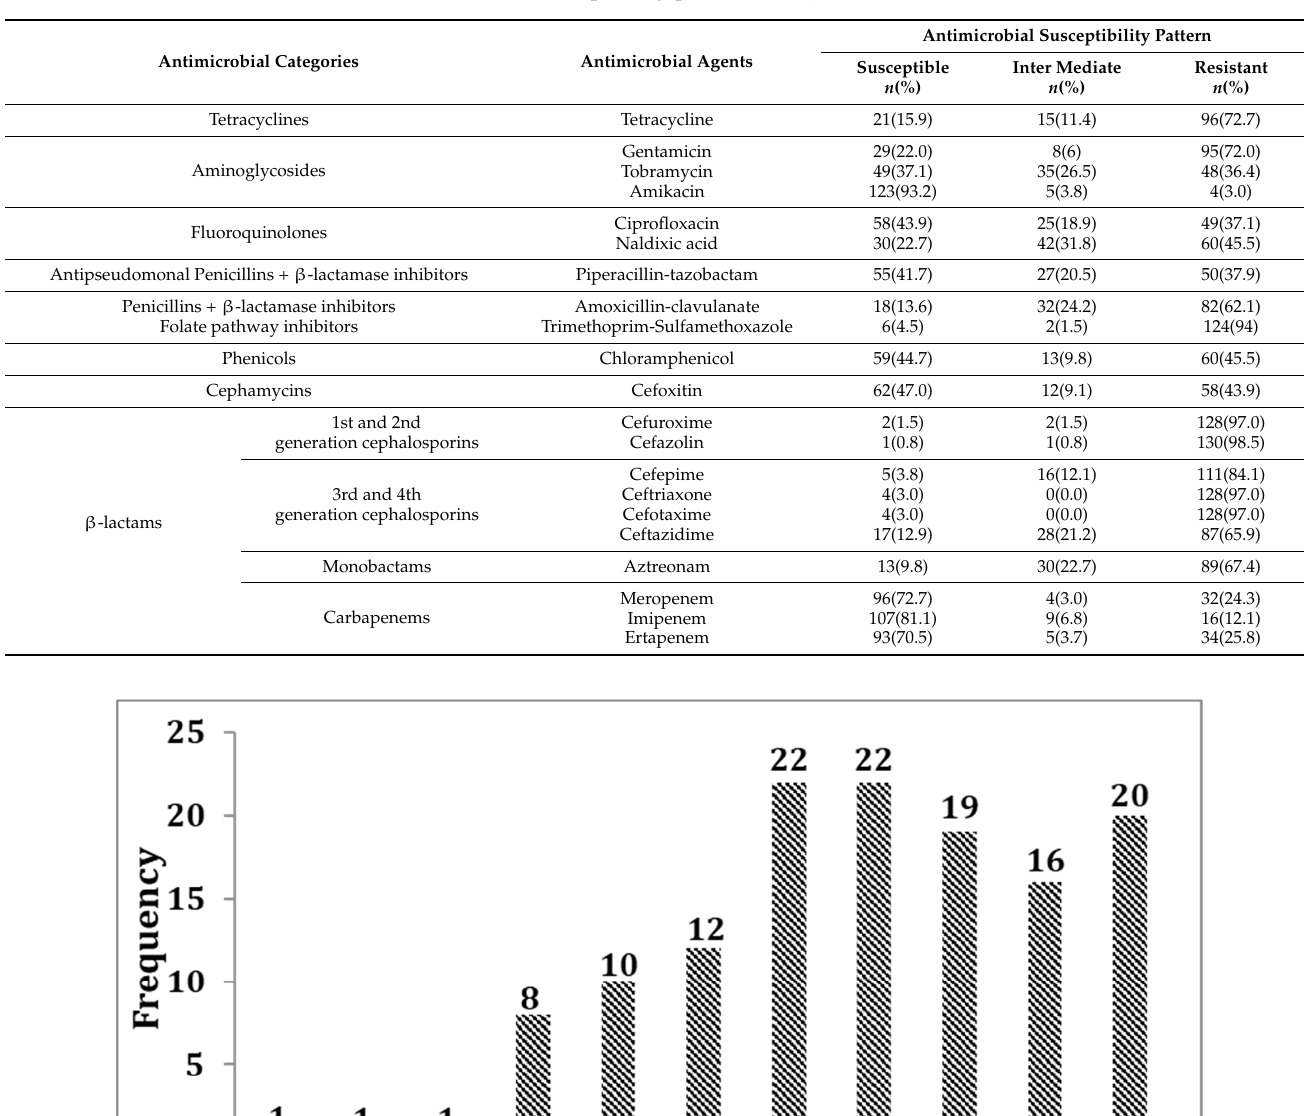
Table 2. Antimicrobial susceptibility patterns of K. pneumoniae isolates.